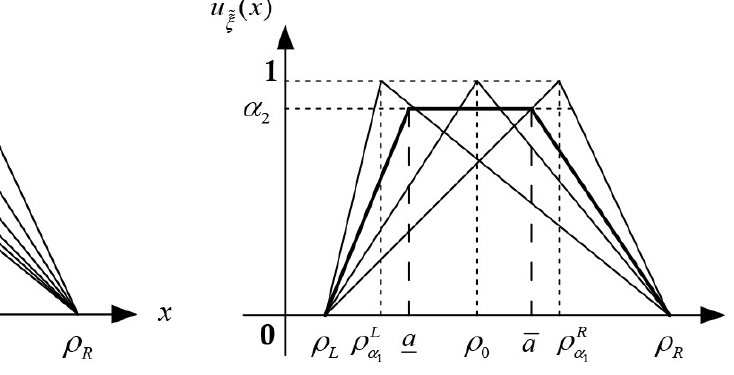
Figure 4. Step 1. Transfer the bi-fuzzy variable Figure 5. Step 2. Transfer the bi-fuzzy